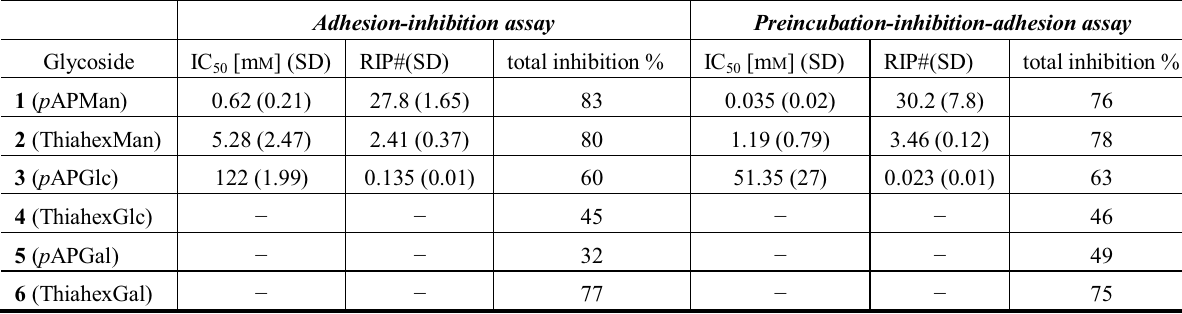
Table 1. Inhibition of type 1 fimbriae-mediated E. coli adhesion to mannan-coated microtiter plates. For IC and RIP values are averaged from mean values from three independent tests. 50 Adhesion-inhibition assay Preincubation-inhibition-adhesion assay